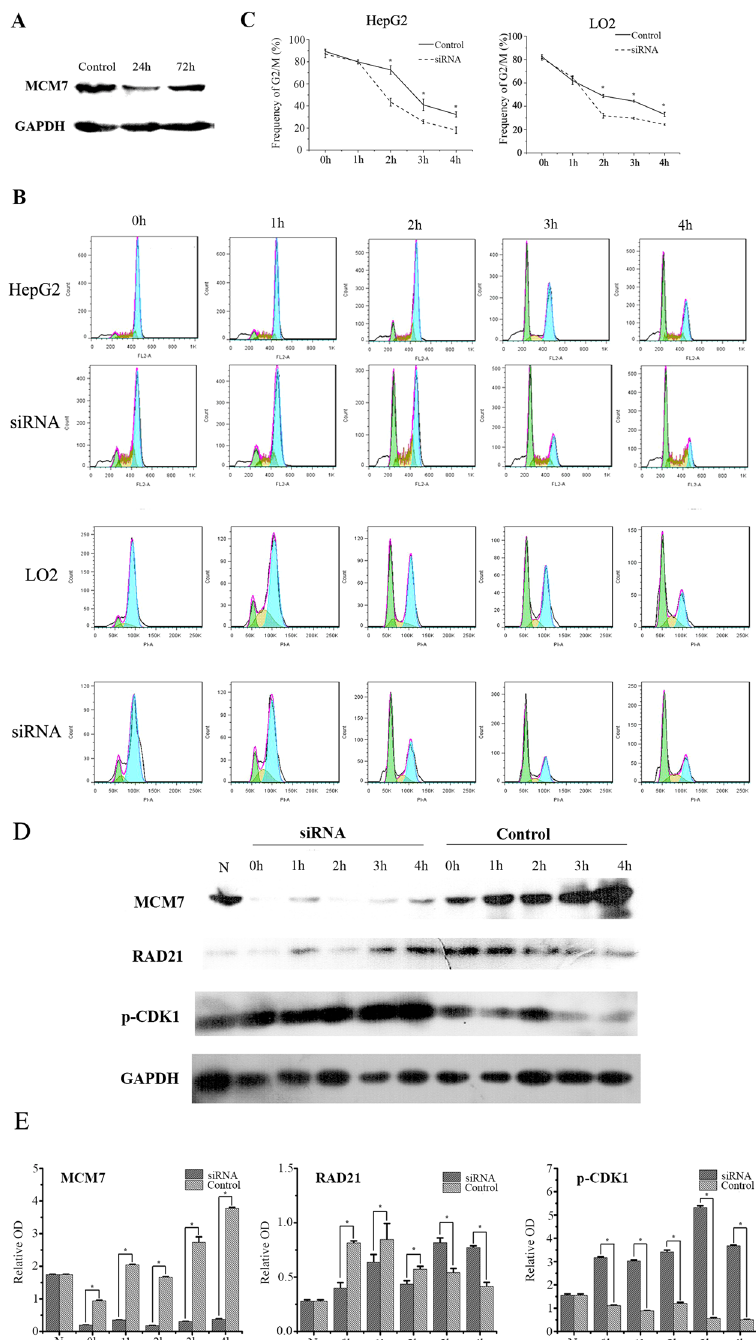
Figure 5. MCM7 depletion promotes mitotic exit. ( A ) HepG2 cells were transfected with MCM7 siRNA or negative control siRNA (Control) for 24 h or 72 h. MCM7 protein level was analyzed by Western blot. GAPDH was used as the loading control. ( B ) HepG2 cells and LO2 cells were transfected with MCM7 siRNA (siRNA) or negative control siRNA (Control) for 12 h, then 0.2 μ g/ml nocodazole was added to cell culture for further 12 h and then incubated in fresh medium for 0 h, 1 h, 2 h, 3 h and 4 h. Cell cycle was analyzed by FACS and data are shown as mean ± SD of three independent experiments ( C ), * P < 0.05. ( D ) MCM7, p-CDK1 and RAD21 were detected by western-blot. GAPDH was used as the loading control. Data are expressed as optical density (OD) fold difference related to GAPDH from 3 duplicate experiments ( E ), * P <